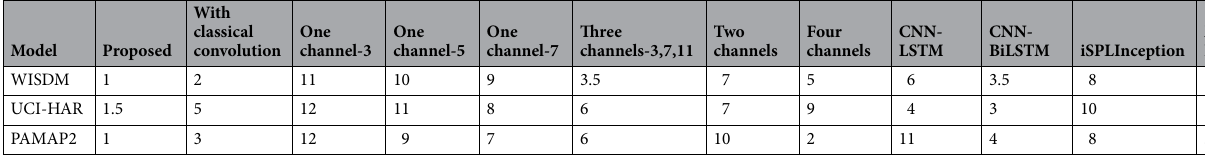
Table 13. Performance ranking of each test model on all benchmark